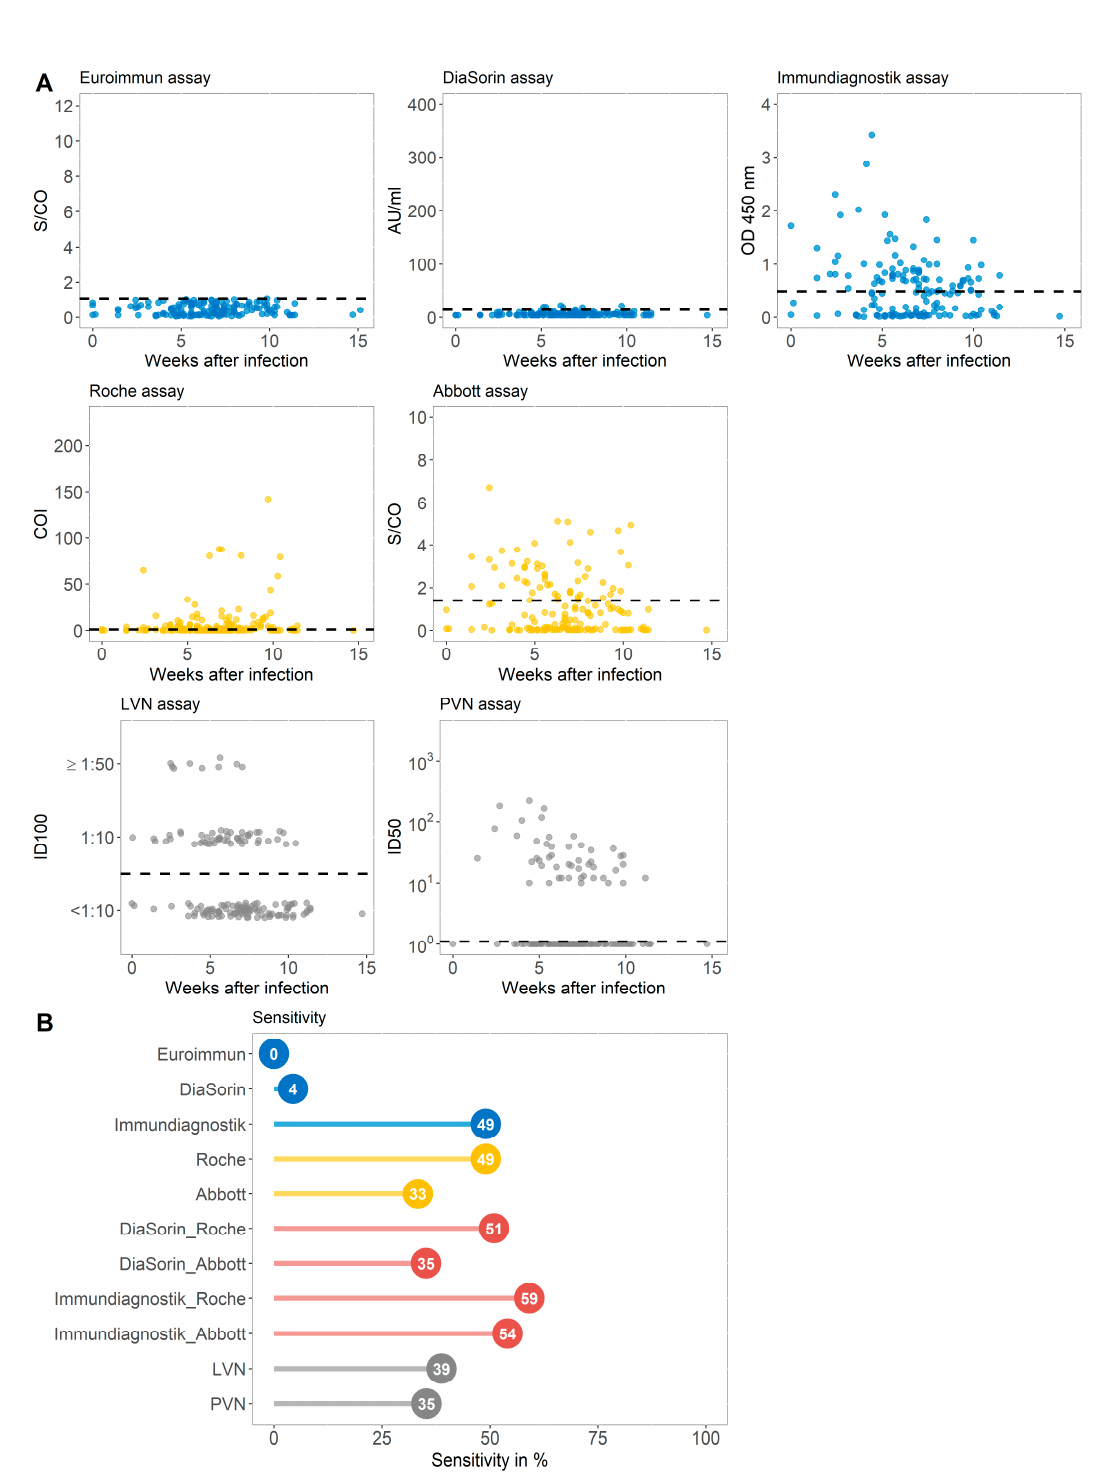
Figure 4. ( A ) Antibody values of five commercially available immunoassays targeting the S (spike) (blue) or the NC (nucleocapsid) protein (yellow) and virus neutralizing assays (grey) displayed against the weeks after infection for each individual from group B. Dashed horizontal lines display cutoff values of individual serological assays. Results of the virus neutralizing immunoassay are categorized into <1:10, 1:10, and ≥ 1:50. ( B ) The sensitivity in % achieved by assays against the S ‐ protein (blue), the NC antigen (yellow), the combination of assays targeting the different proteins (red), and the VN test (grey) for group B. LVN, live virus neutralization assay; PVN, pseudovirus neutralization assay; ID100, 100% inhibitory dilution; ID50, 50% inhibitory dose.